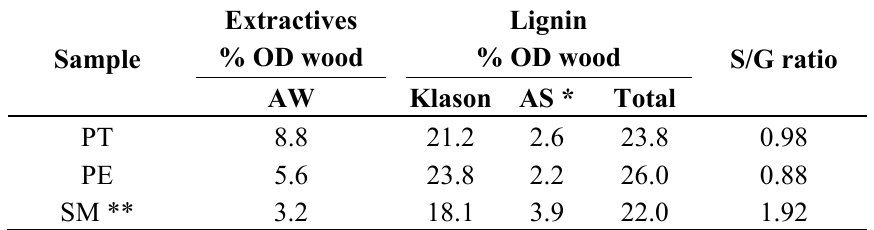
Table 1. The contents of extractives and lignin, and S/G ratio in PT, PE, and SM.